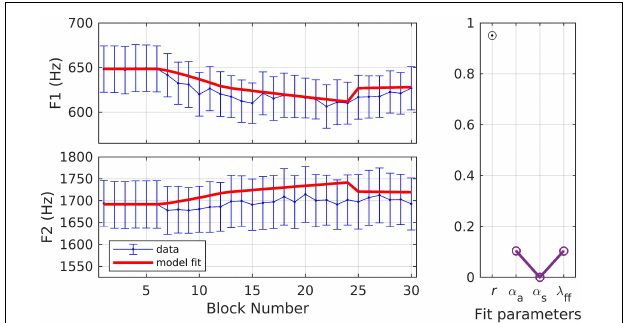
FIGURE 5 | Simulation 3: model fits of a dataset with perturbations applied to both F1 and F2; F1 and F2 data are fit simultaneously (data from Daliri et al., 2018). (Left) Mean and standard error of experimental data in blue; model fit in red. (Right) Fit quality and optimized parameter values ( r = correlation coefficient; α A = auditory feedback control gain, α s = somatosensory feedback control gain, and λ FF = learning rate).